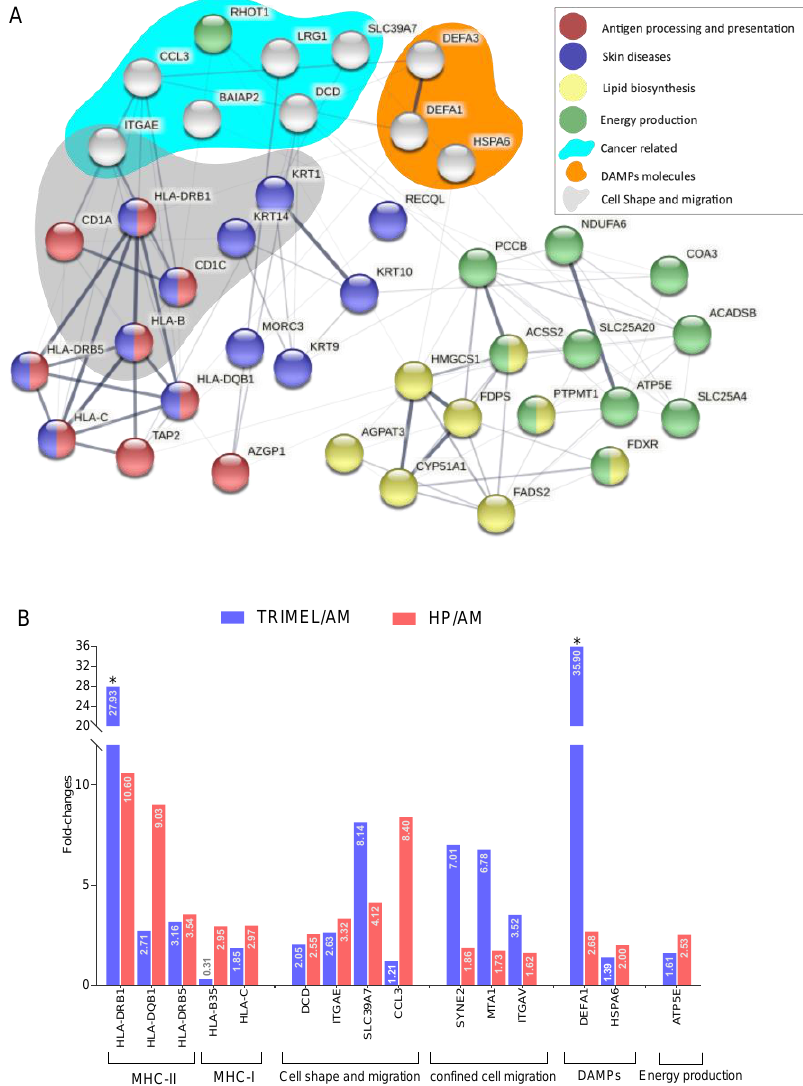
Figure 2. Protein–protein interaction network and fold change of relevant proteins in HP- and TRIMEL-stimulated cells. ( A ) Protein interactome of exclusive and more abundant proteins in HP- stimulated cells compared with AM. Interactome of proteins selected from a differentiated panel of 83 proteins, of which 31 are exclusive and 52 are in greater abundance ( ≥ 2 fold-change), shows proteins related to antigen processing and presentation (red), energy production (green) and lipid biosynthesis (yellow). In addition, proteins associated with cancer development (cyan shadow), changes in cell shape and cell migration (grey shadow), and proteins with DAMP functions (orange shadow) were also identified. Proteins were found more abundant considering a cutoff p < 0.01 or abs (log2 (FC)) > 1; ( B ) comparison of TRIMEL/AM and HP/AM fold-changes of selected proteins. In both TRIMEL- and HP-stimulated cells, there were several proteins with a higher abundance regarding AM condition. In the TRIMEL group, the most abundant proteins were DEFA1 (35.9 fold- change), HLA-DRV1 (27.93 fold-change) and SLC39A7 (8.14 fold-change), while, in the HP group, the most abundant proteins were: HLA-DRB1 (10.8 fold-change), HLA-DQB1 (9.03 fold-change) and CCL3 (8.4 fold-change). Confined cell migration related proteins were more abundant in the TRIMEL group compared with HP-stimulated cells. * p < 0.05.